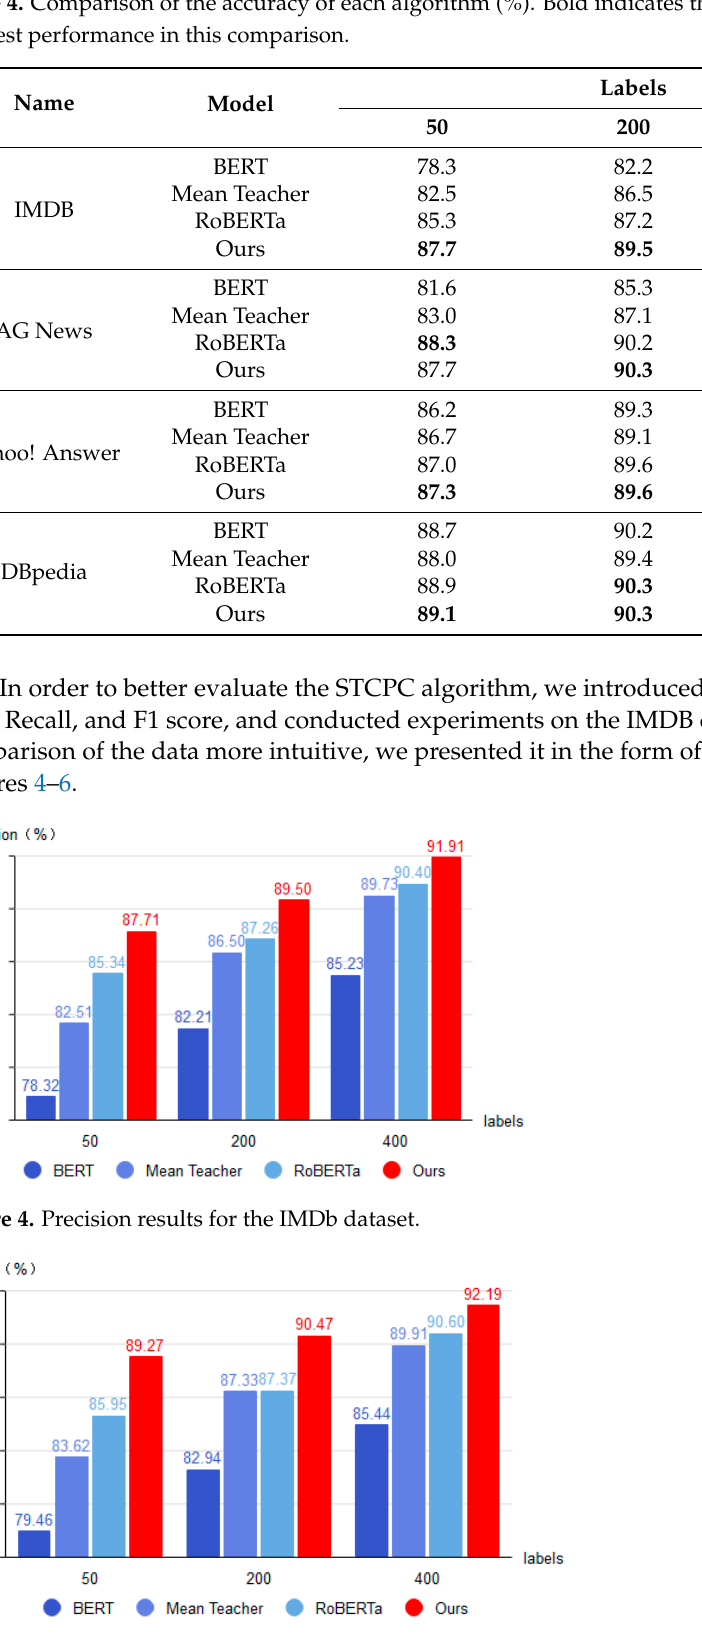
Figure 6. F1 score results for the IMDb dataset. From the comparison of the three plots in Figures 4–6, we can find that the STCPC algorithm achieves good results for all three metrics, which indicates that the STCPC al- gorithm model is better than the compared methods in terms of its ability to distinguish negative samples, its ability to identify positive samples and its robustness. This shows that STCPC has significant significance in improving the classification effect of the model, which can effectively reduce overfitting and improve the classification performance of the model.